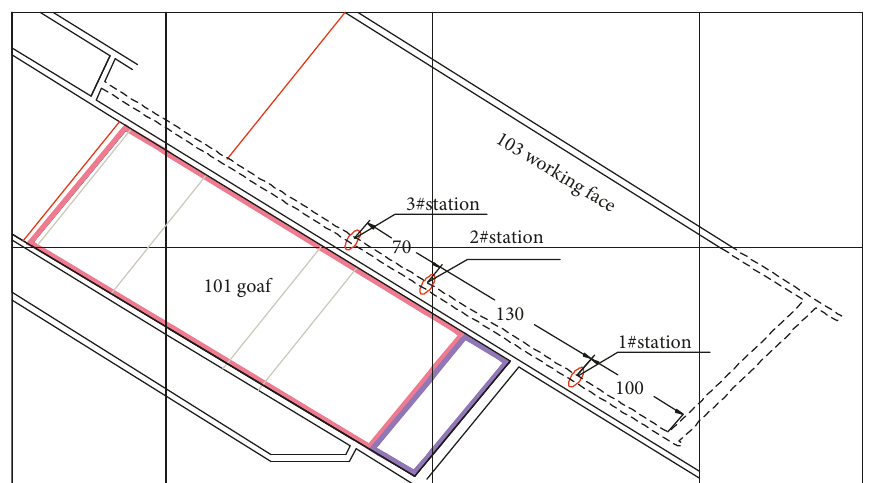
Figure 18: Schematic diagram showing the layout of stations #1, #2, and